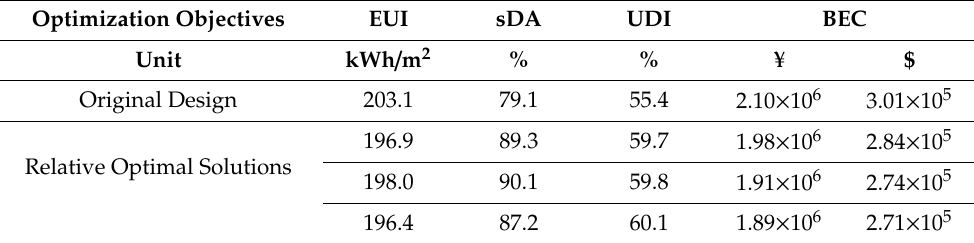
Table 7. Optimization objectives of the original design and the relative optimal